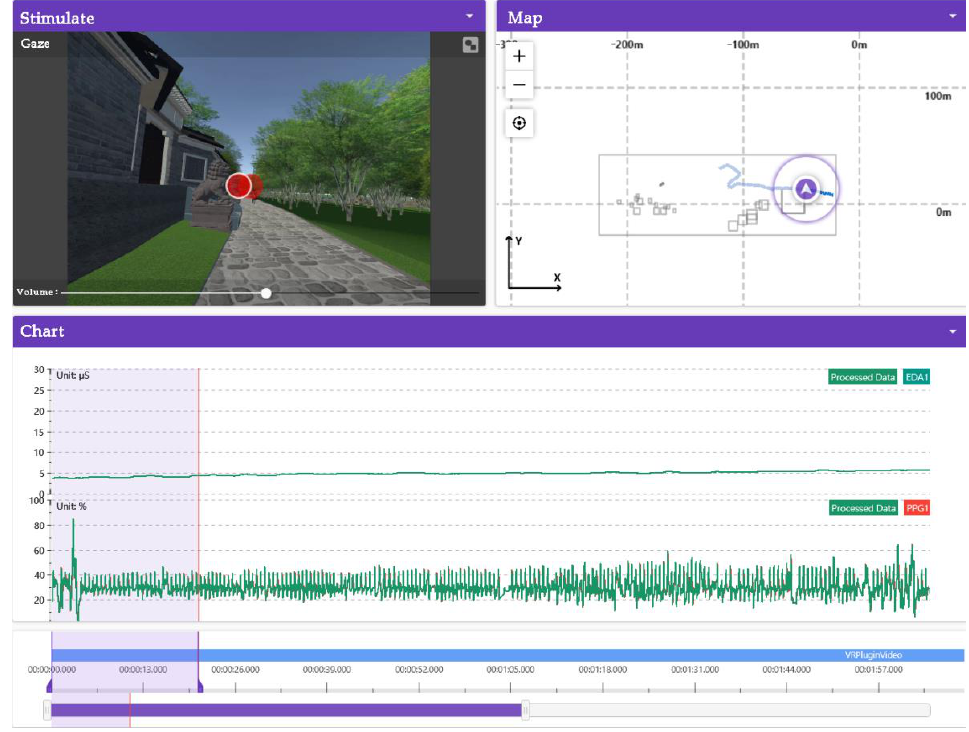
Figure 4. Experimental scene and data monitoring interface. Source: ErgoLAB platform exported, data detection screen after subject’s roaming experience, EDA, PPG data.